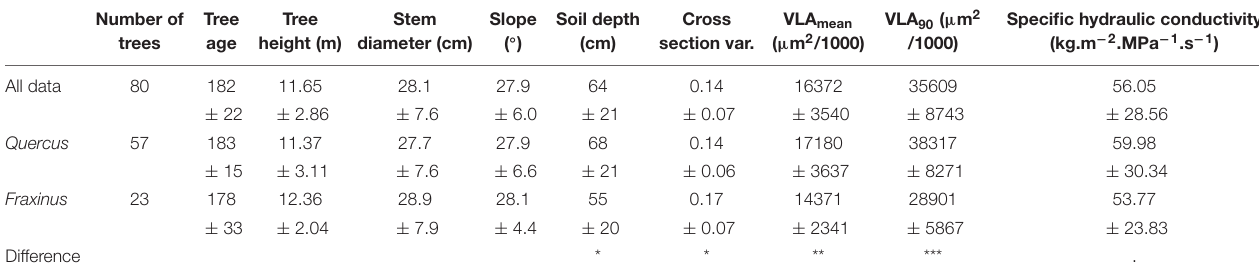
TABLE 1 | Basic characteristics of the analyzed trees. Number of Tree trees